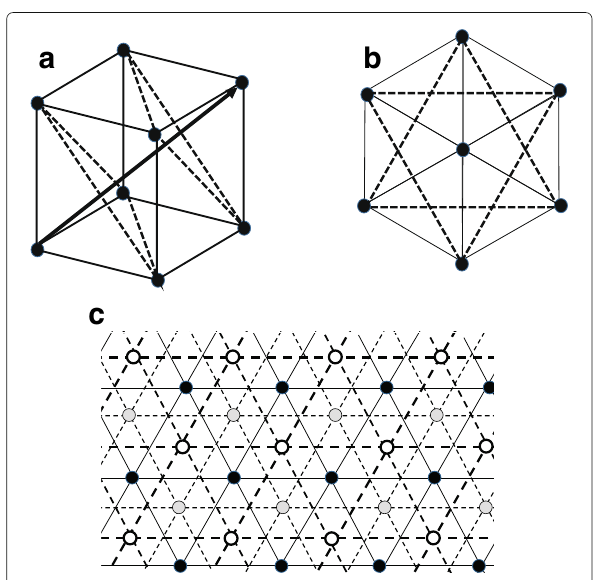
Fig. 4 SC lattice and its ( 1,1,1 ) -direction. The cube in ( a ) shows the parallel triangles whose normal direction is ( 1,1,1 ) in the simple cubic lattice. If one looks at the cube from the ( 1,1,1 ) -direction, then the image is as depicted in ( b ). Furthermore, if one projects the whole SC lattice to the plane perpendicular to the ( 1,1,1 ) -direction, then one gets the image as in ( c ), where the black, gray and white dots correspond to the three sheets A d ( 0 ) , A d ( 1 ) and A d ( 2 ) , respectively